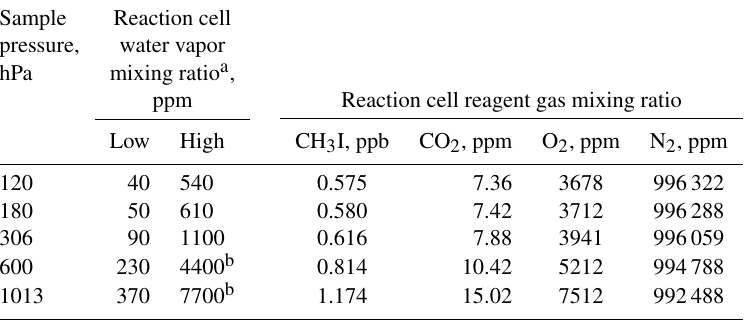
Table 3. Laboratory instrument calibration conditions: sample inlet pressure, reaction cell water vapor mixing ratios, and reagent gas reaction cell mixing ratios.